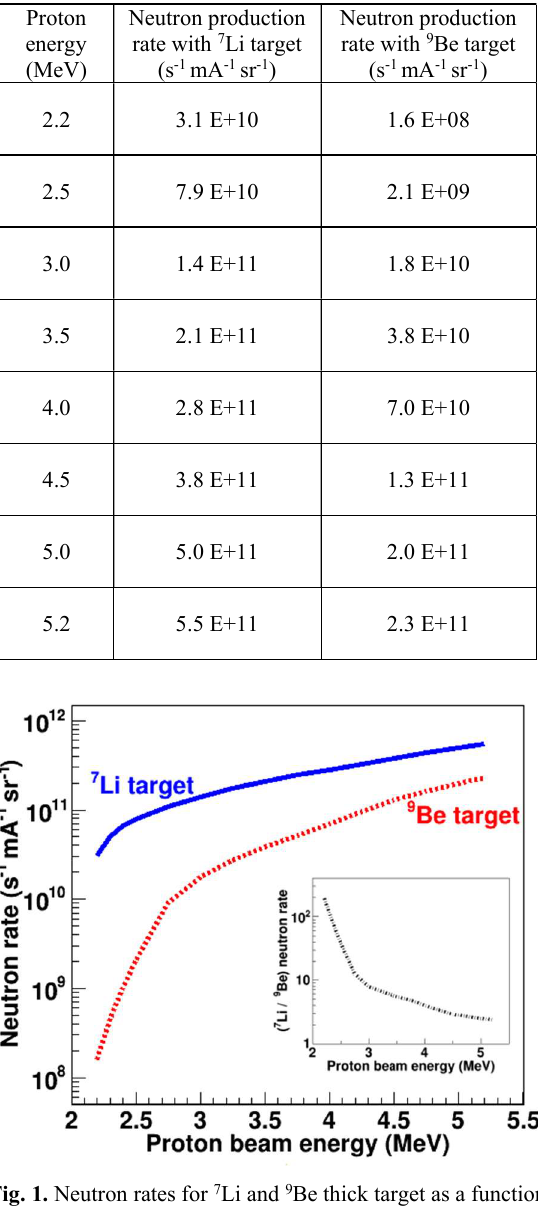
Fig. 1. Neutron rates for 7 Li and 9 Be thick target as a function of proton beam energy. See text for more details. The energy evolution of the ratio of the neutron rates for the two targets is illustrated in the